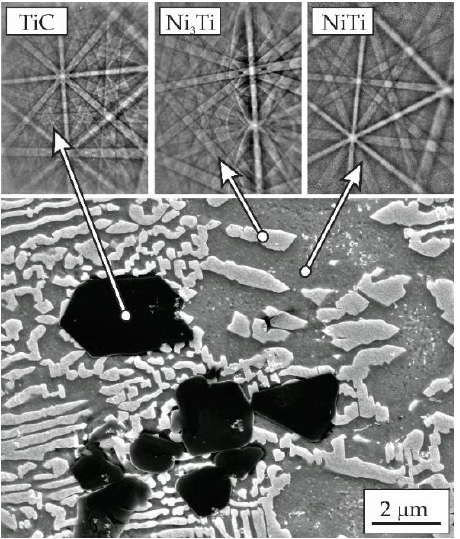
Figure 6. Microstructure of strand 2: SEM image. Three phases were observed. Strongly prevailing cubic NiTi (light grey), hexagonal Ni 3 Ti (almost white), and some small groups of TiC-particles (dark, almost black). Kikuchi patterns of these three phases, obtained by the EBSD system, are presented on the top.